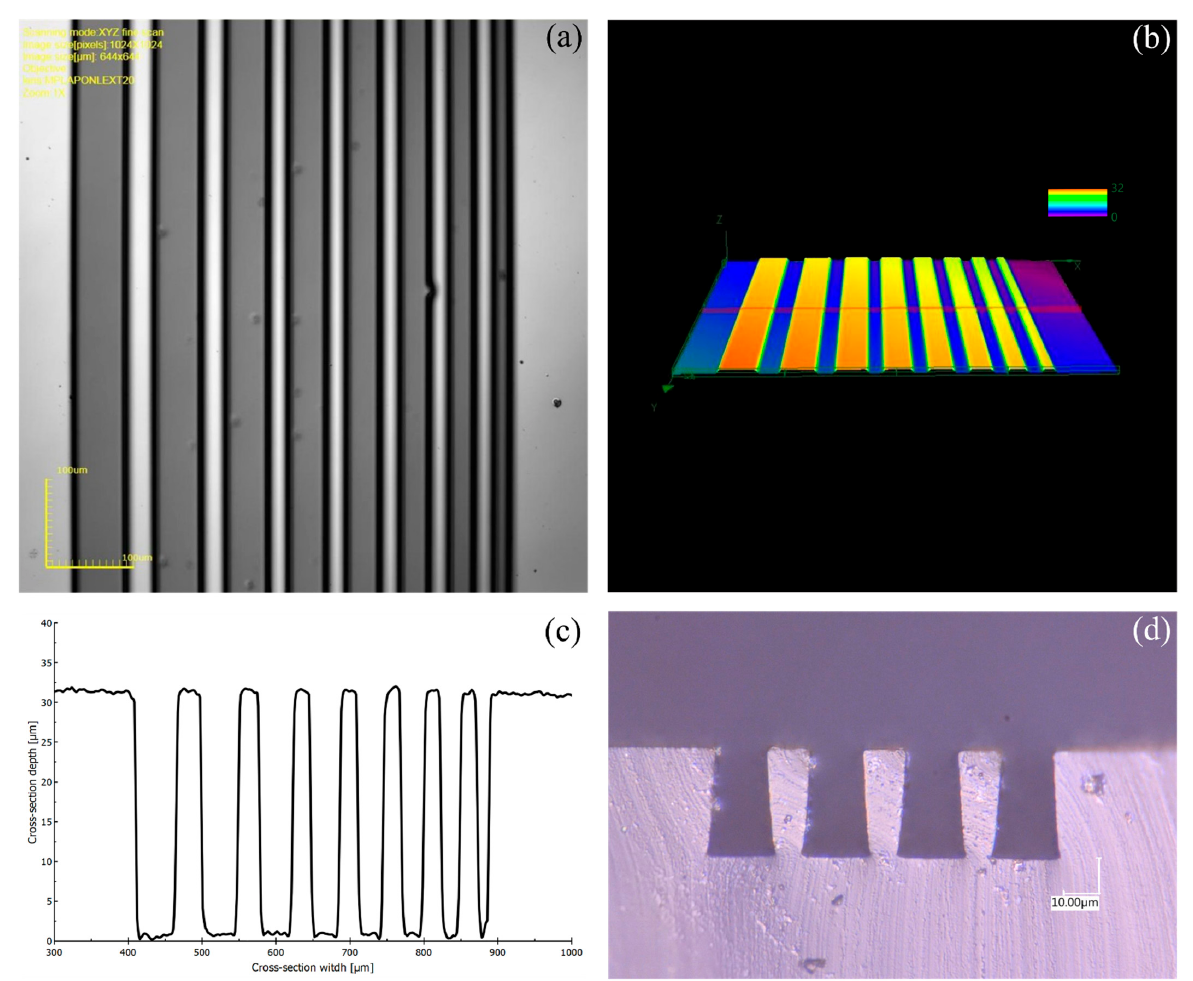
Figure 3. PDMS structures (before bonding) with a depth of about 30 µm (and widths of 10, 20, 25, 30, 35, 40, 45, and 50 µm) observed with an Olympus LEXT OLS4100, where ( a ) top view, ( b ) 3D visualization of the structure, and ( c ) a cross-section profile taken along the line marked in the pre- vious panel. ( d ) A photo of the cross-section of another PDMS structure (produced using mold from the same series) with a height of 30 µm obtained using a KEYENCE VHX-5000 microscope.